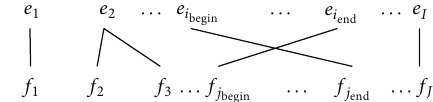
Figure 4: Alignments with a cross link involving distant